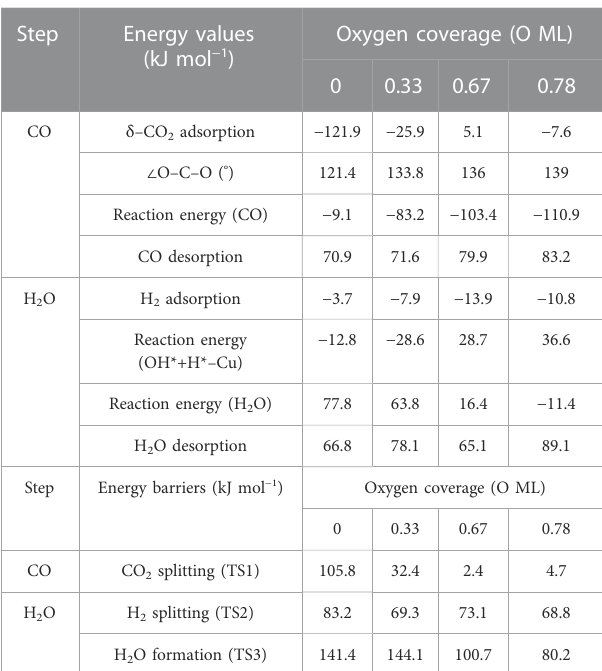
TABLE 3 Summary of energy values (adsorption, release, and overall reaction) and energy barriers (transition states) for each step on RWGS with Cu/Mo 2 C system in kJ mol − 1 .